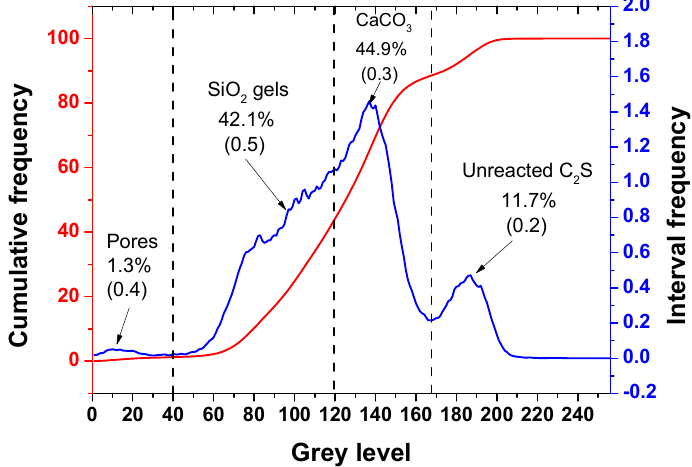
Figure 4. The gray level frequency and the cumulative distribution curves for different phases.